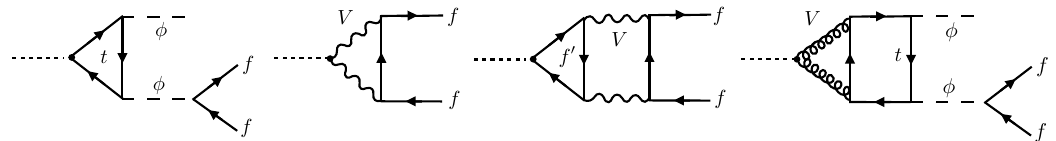
Figure 1 . Logarithmically enhanced loop diagrams (in lowest order) responsible for the RG evolution effects proportional to c (last graph) in the results shown in